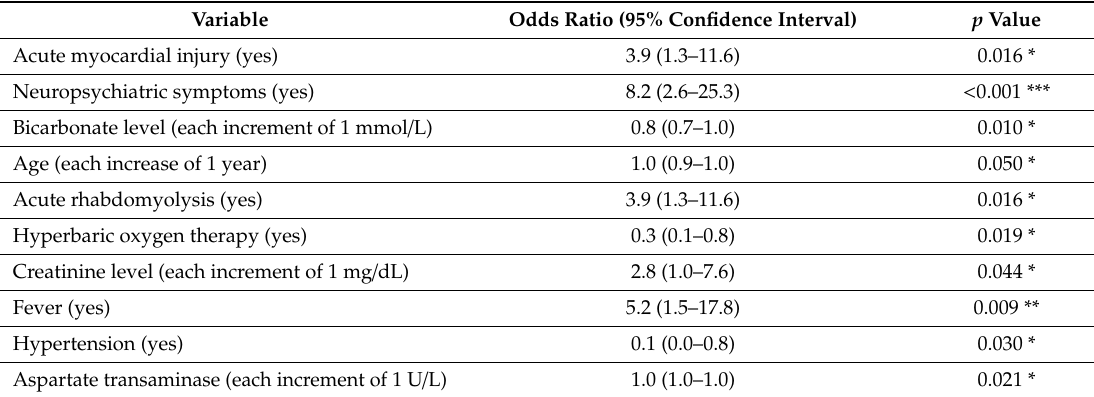
Table 2. Univariable logistic regression analysis of predictors for globus pallidus necrosis ( n = 67). Variable Odds Ratio (95% Confidence Interval)